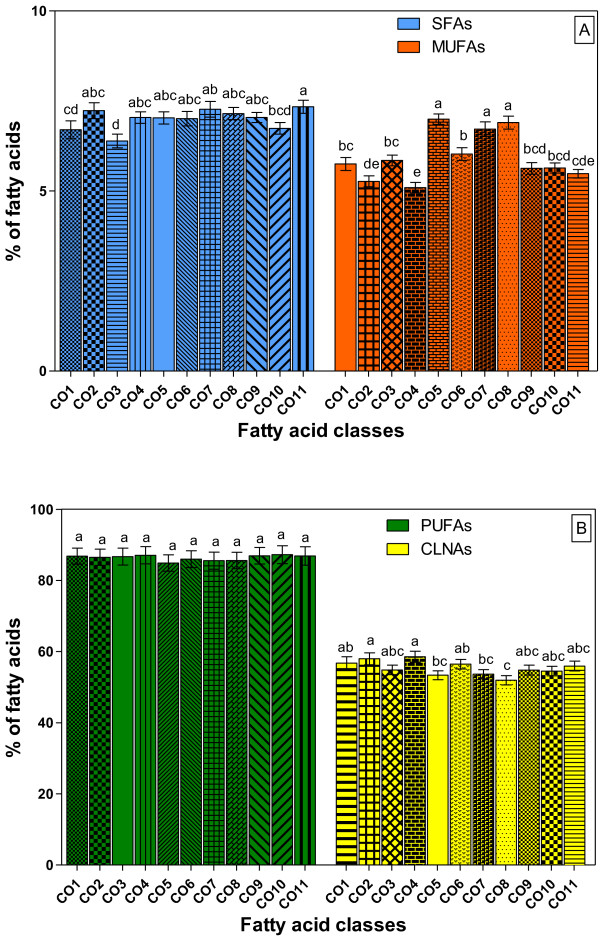
Comparative representation of fatty acid classes from total lipids of different genotypes of pot marigold (Calendula officinalis L.) seed oils. CO1- CO11, pot marigold (Calendula officinalis L.) genotypes. Values are mean ± SD of three samples, analyzed individually in triplicate (n = 3x3). Values with different letters (a-e) are significantly different (p < 0.05), using ANOVA "Tukey's Multiple Comparison Test". SFAs- saturated fatty acids, MUFAs- monounsaturated fatty acids, PUFAs- polyunsaturated fatty acids, CLNAs- conjugated linolenic acids.